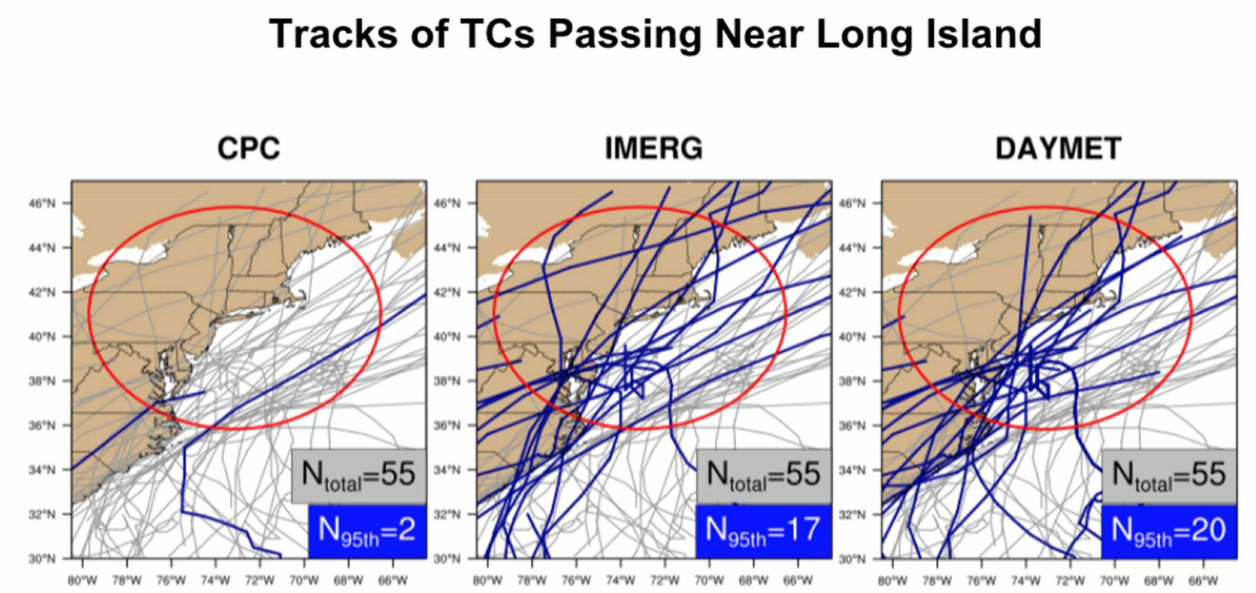
Figure 5. For 2001–2020, the blue tracks show the TCs that caused 95th-percentile precipitation events on Long Island, while the gray tracks show TCs that passed through the red circle (5 ◦ circle around the center of Long Island) but did not cause 95th-percentile precipitation events. The gray boxes show the total number of tracks that passed within the red circle, and the blue boxes show the number of tracks that contributed to 95th-percentile precipitation events (i.e., the number of blue